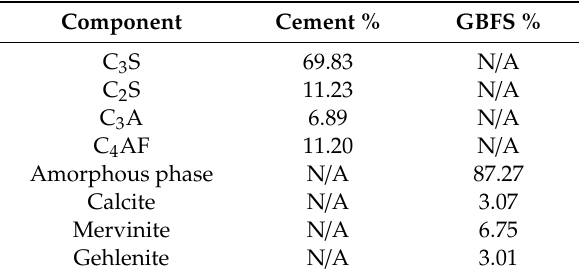
Table 2. Phase compositions o fused